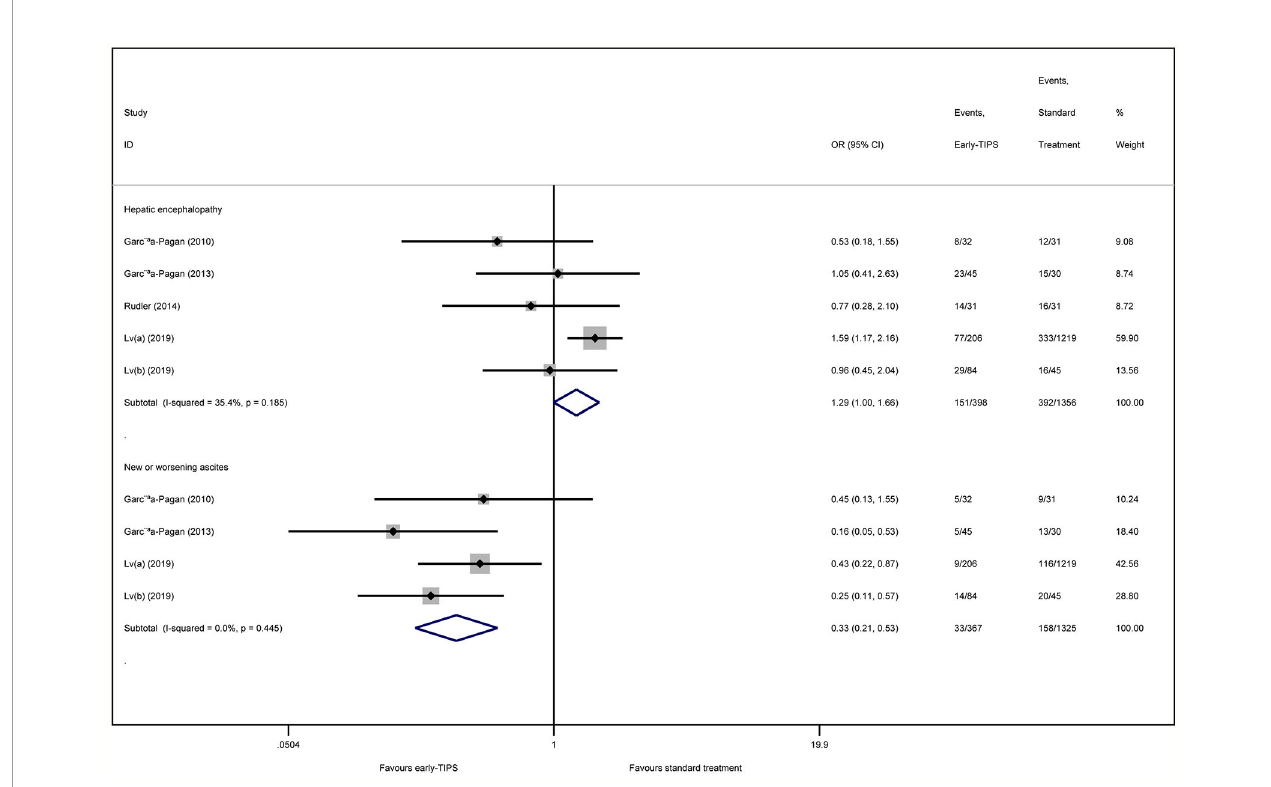
FIGURE 4 | Forest plot demonstrating risk of hepatic encephalopathy and new or worsening